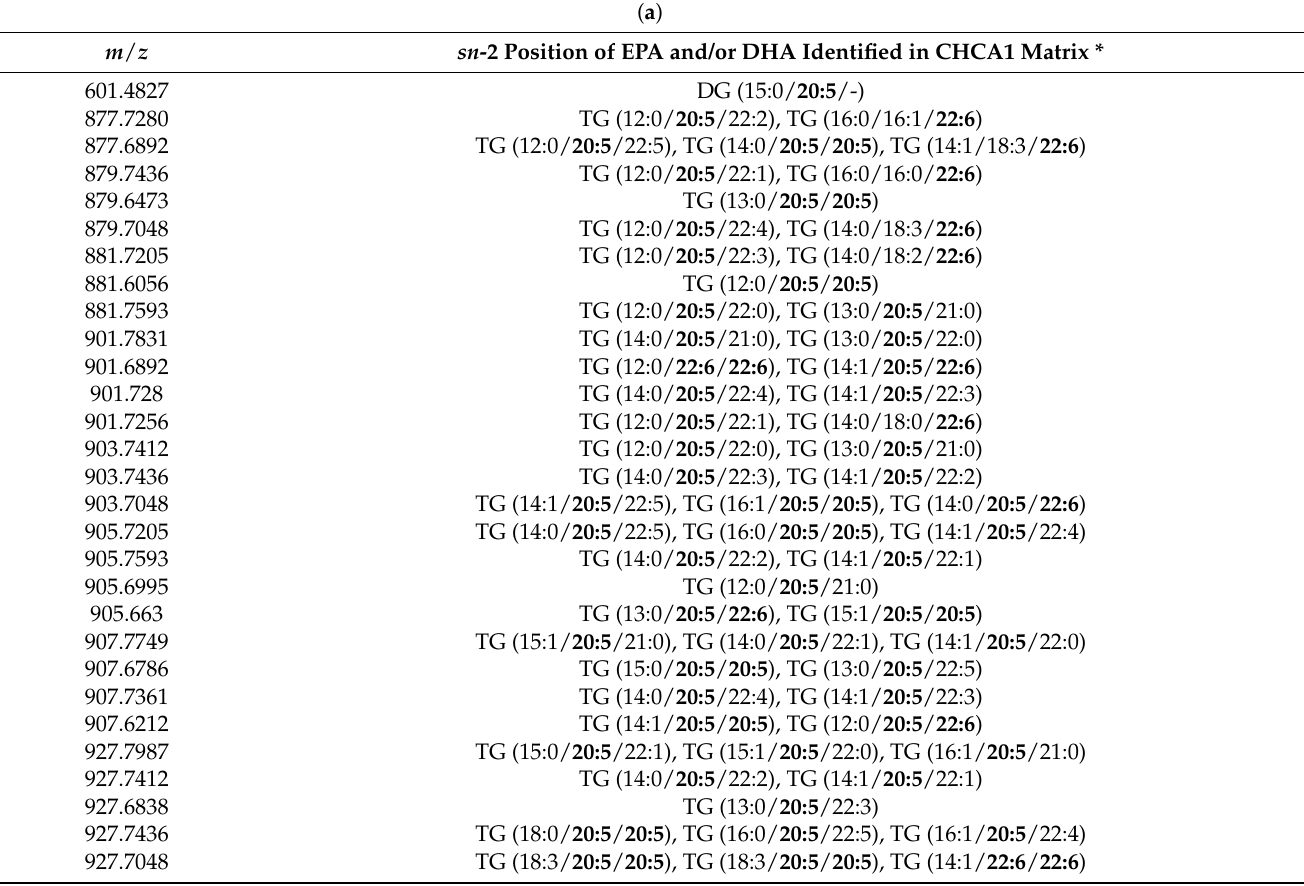
Table 3. ( a ) sn -2 position of EPA/DHA in the DG and TG of DRCSO identified with the CHCA1 matrix *; ( b ) position of FAs in the MG of DRCSO identified with the CMBT1 matrix *; ( c ) position of FAs in the DG of DRCSO identified with the DHB1 matrix *; ( d ) sn -2 position of EPA/DHA in the DG and TG of DRCSO identified with the DHB2 matrix *; ( e ) summary of the presence of EPA/DHA in the DG/TG of DRCSO identified in the different matrices *. ( a ) m / z sn -2 Position of EPA and/or DHA Identified in CHCA1 Matrix